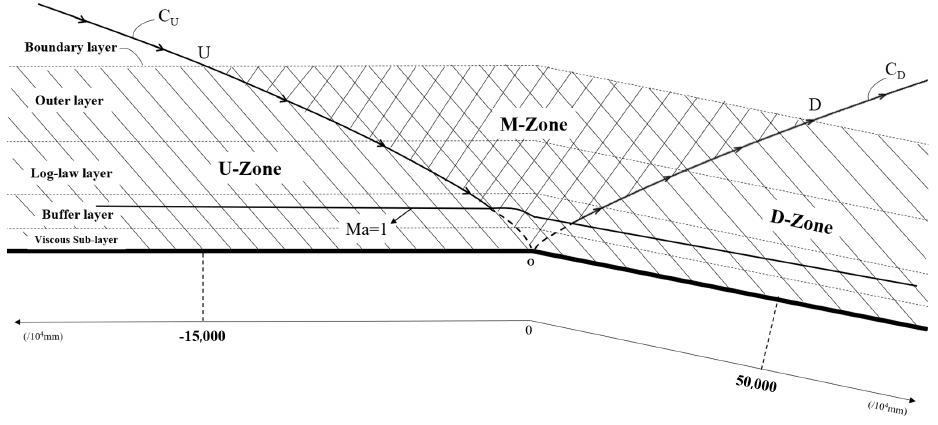
Figure 6. The U-zone, M-zone and D-zone. The distribution of the measuring points is shown in Figure 7a,b. Measuring points are evenly distributed in U-zone, D-zone, M-zone, and along the vertical direction of the wall surface. The measuring points are arranged at different layers within the boundary layer in these three